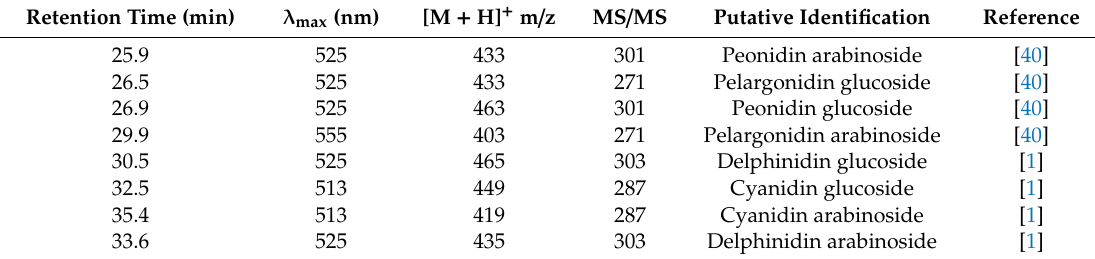
Table 3. Putative identification of anthocyanins present in the chromatograms obtained after analysis by HPLC-MS / MS of the extracts of strawberry-tree fruit obtained after microwave irradiation and their corresponding retention time (Rt), maximum absorption wavelength ( λ max ), precursor ion ([M + H] + ) and product ions obtained by MS /